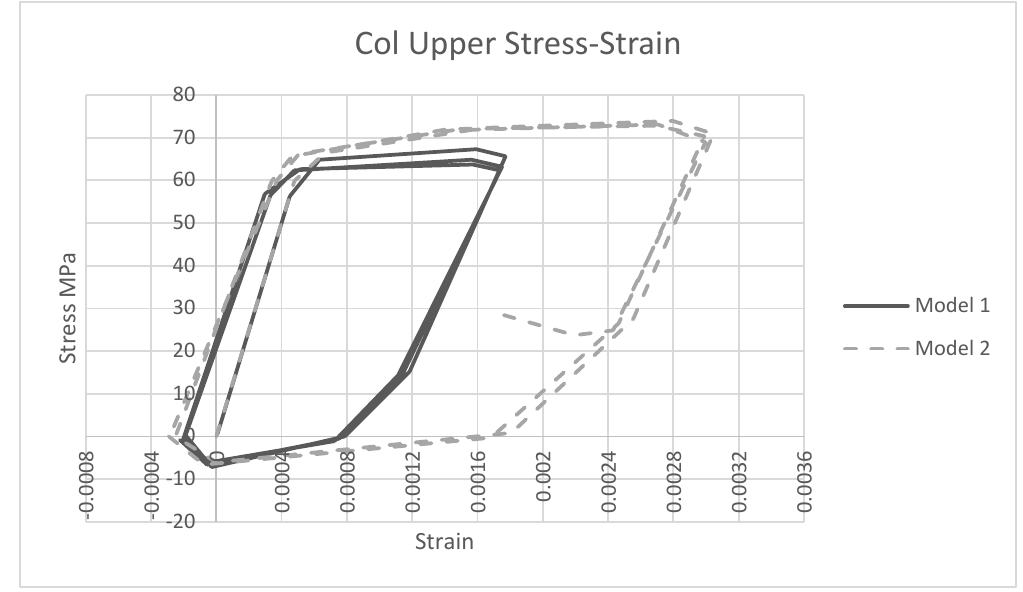
Fig. 19. The stress-strain curve of the upper critical element in the column (under the joint